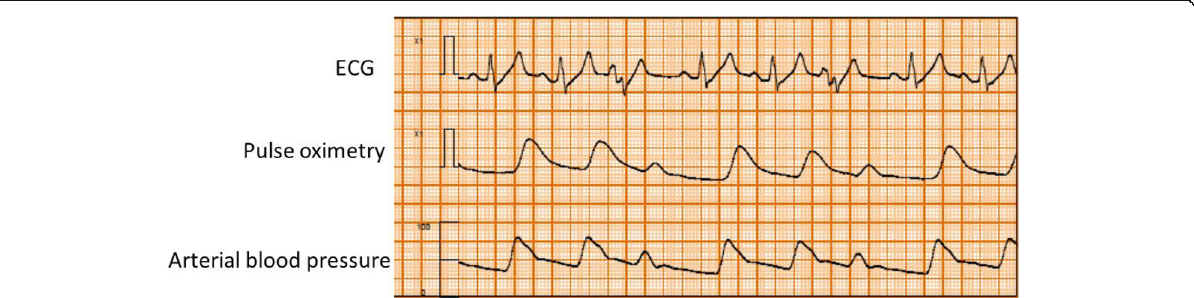
Fig. 1 Preoperative electrocardiogram. The tracing of lead II showed complete right bundle branch block and delta waves with WPW syndrome